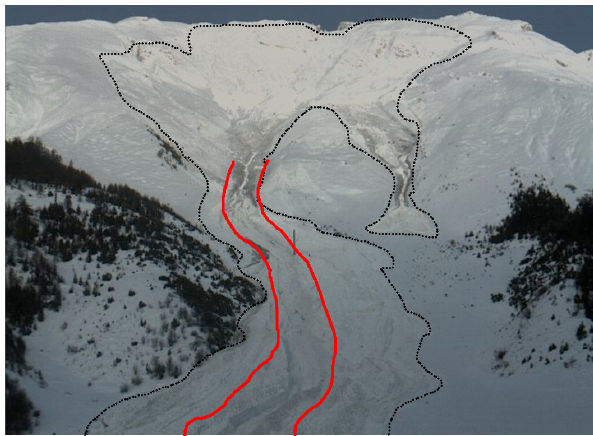
Fig. 13. Estimated boundaries of avalanches on 6 and 7 Decem- ber 2010. Red line: Channel of Avalanche 4, delimited by levees. Avalanche 4 was probably released from the far left of Crˆeta-Besse 1 and from part of Crˆeta-Besse 2. The dashed black line indicates the total area affected by the avalanche activity on 6 and 7 Decem- ber 2010 (photo source: